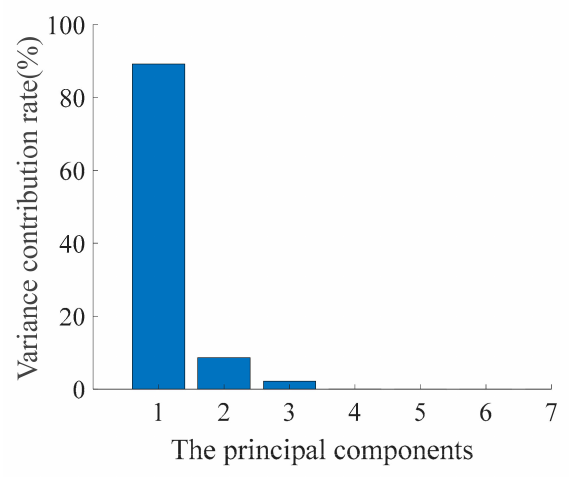
Figure 3. Variance contribution rates of each principal component. Table 3. Linear transformation coefficients of principal component 1.